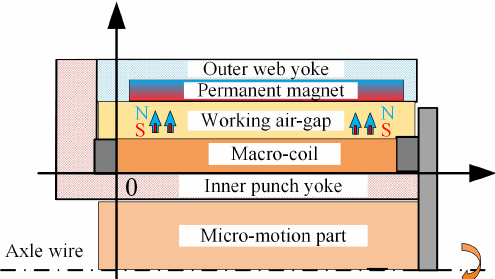
Figure 5. Relationship curve between the axial magnetic field and axial displacement of the macro-motion coil.